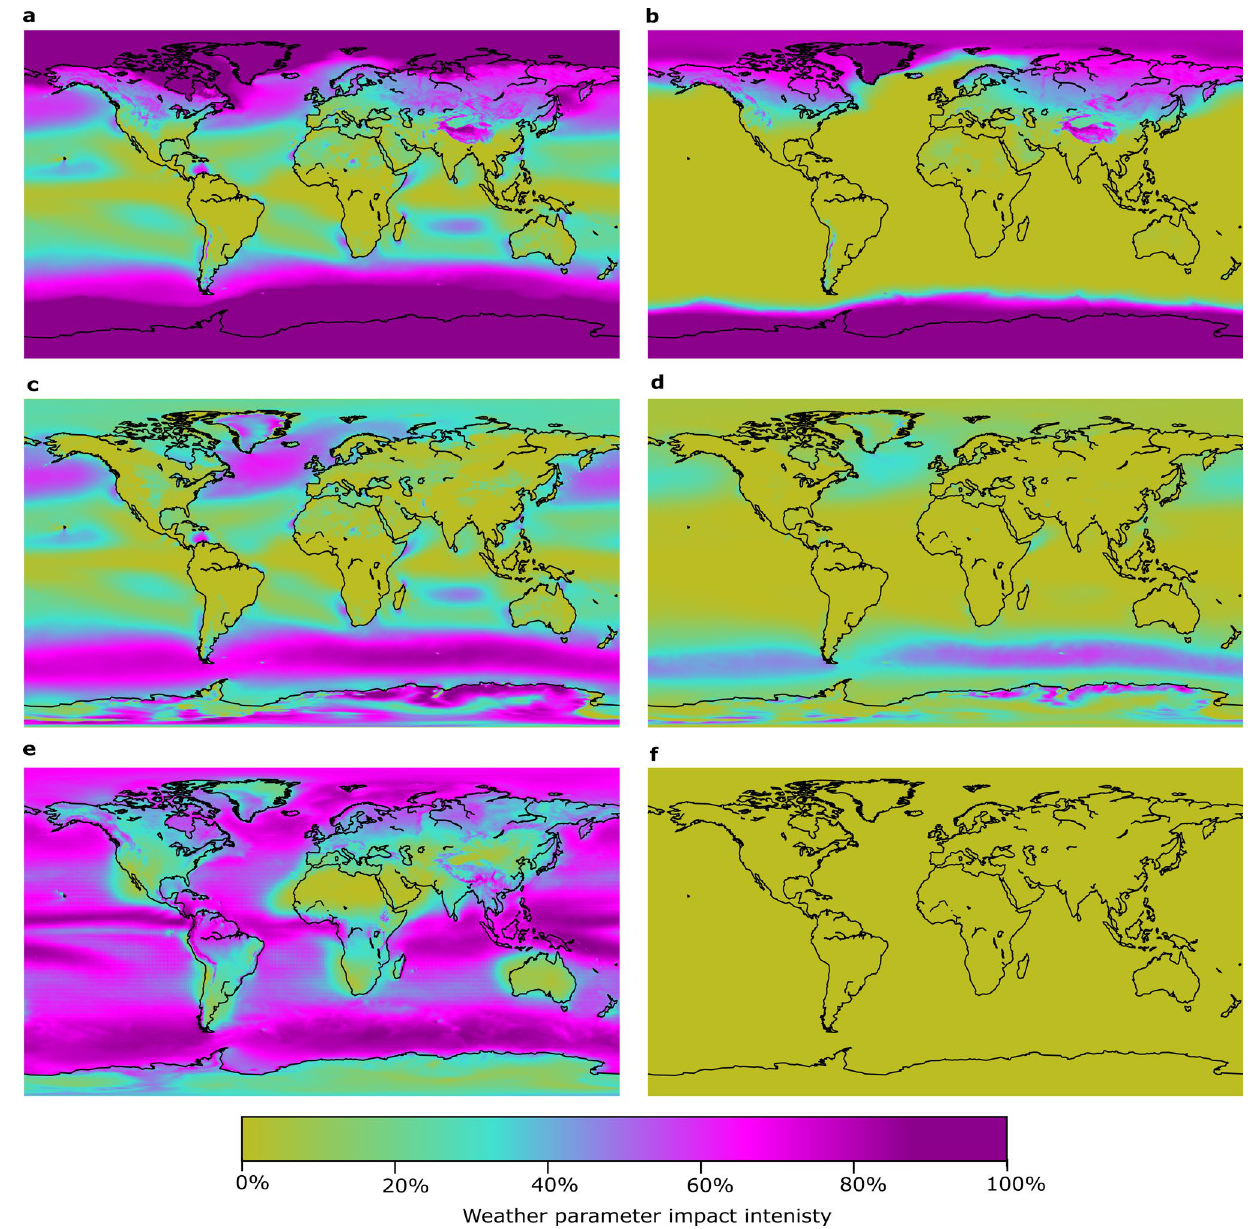
Figure 3. Global relative impact intensity of weather variables showing the impact of temperature on the flyability of CD ( a ) and WRD ( b ); the impact of wind speed on the flyability of CD ( c ) and WRD ( d ); and the impact of precipitation on the flyability of CD ( e ) and WRD ( f ). Impact intensity is the percentage of time that a weather variable prevents flight, independent of other weather